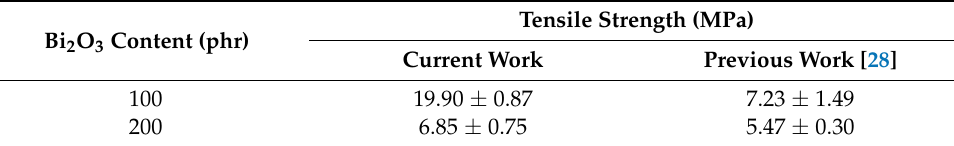
Table 4. Mean ( ± standard deviation) tensile strength of nano-Bi 2 O 3 /SVNRL composites in current work compared to previous work [28].